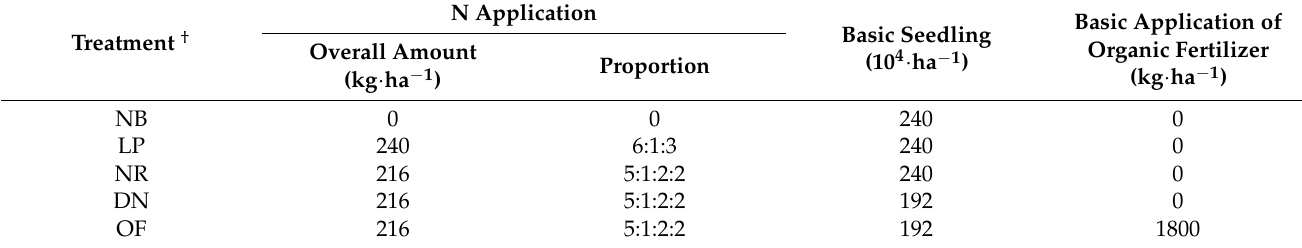
Table 1. Cultivation practices for different treatments.